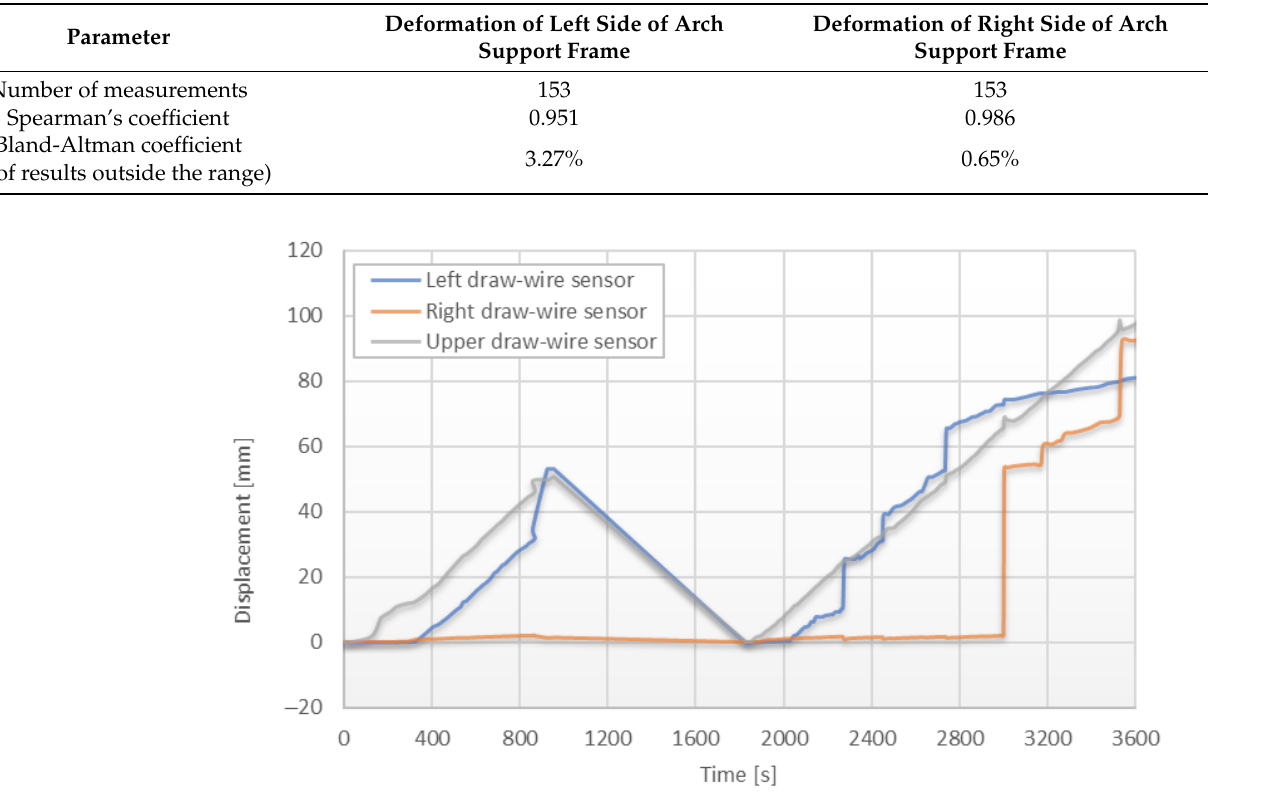
Figure 26. Results of displacement measurements with use of draw-wire sensors (the second step of tests).